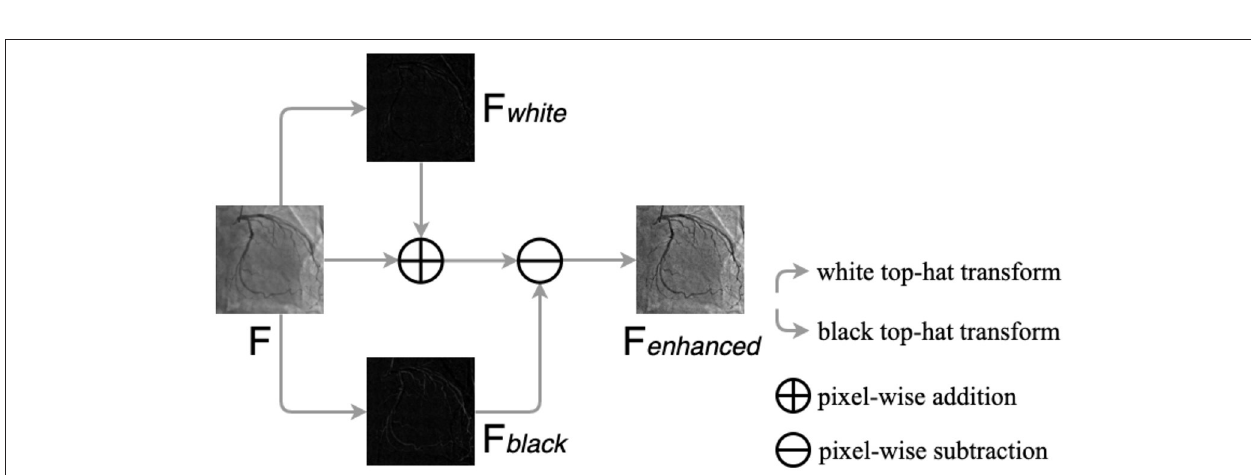
FIGURE 4 | The angiograms are pre-processed by the two strategies. The first column (A) : original angiograms; the second column (B) : angiograms after Top-hat transform; the third column (C) : angiograms after CLAHE.